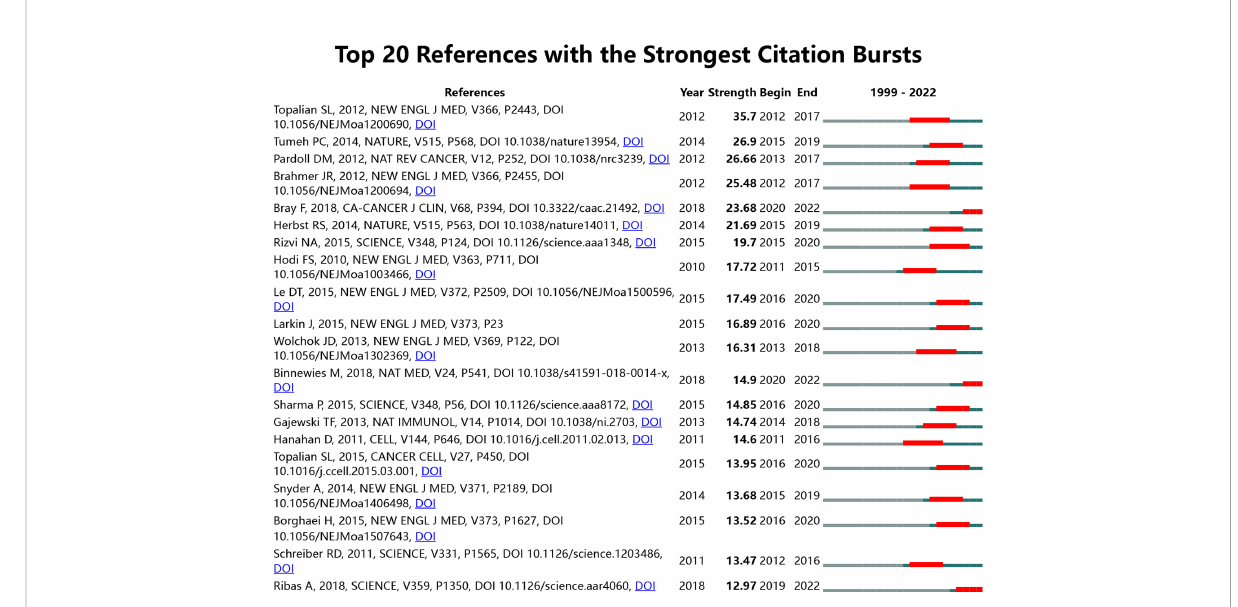
FIGURE 10 Visual analysis of references bursts. The strength re fl ects the cited frequency. The red bar indicates citation frequency; the green bars indicate fewer